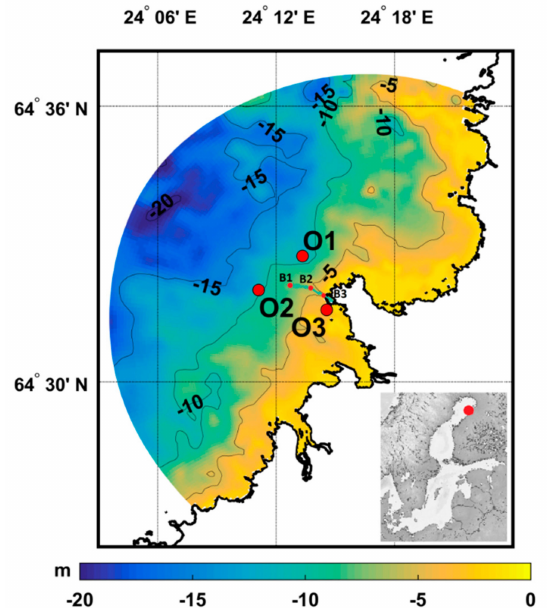
Figure 2. Hanhikivi model domain and bathymetry near the Hanhikivi peninsula. Points O1, О 2, О 3 indicate the location of granulometric measurement sites. Points B1, B2, B3 show the locations along the navigation channel chosen for sedimentation rates